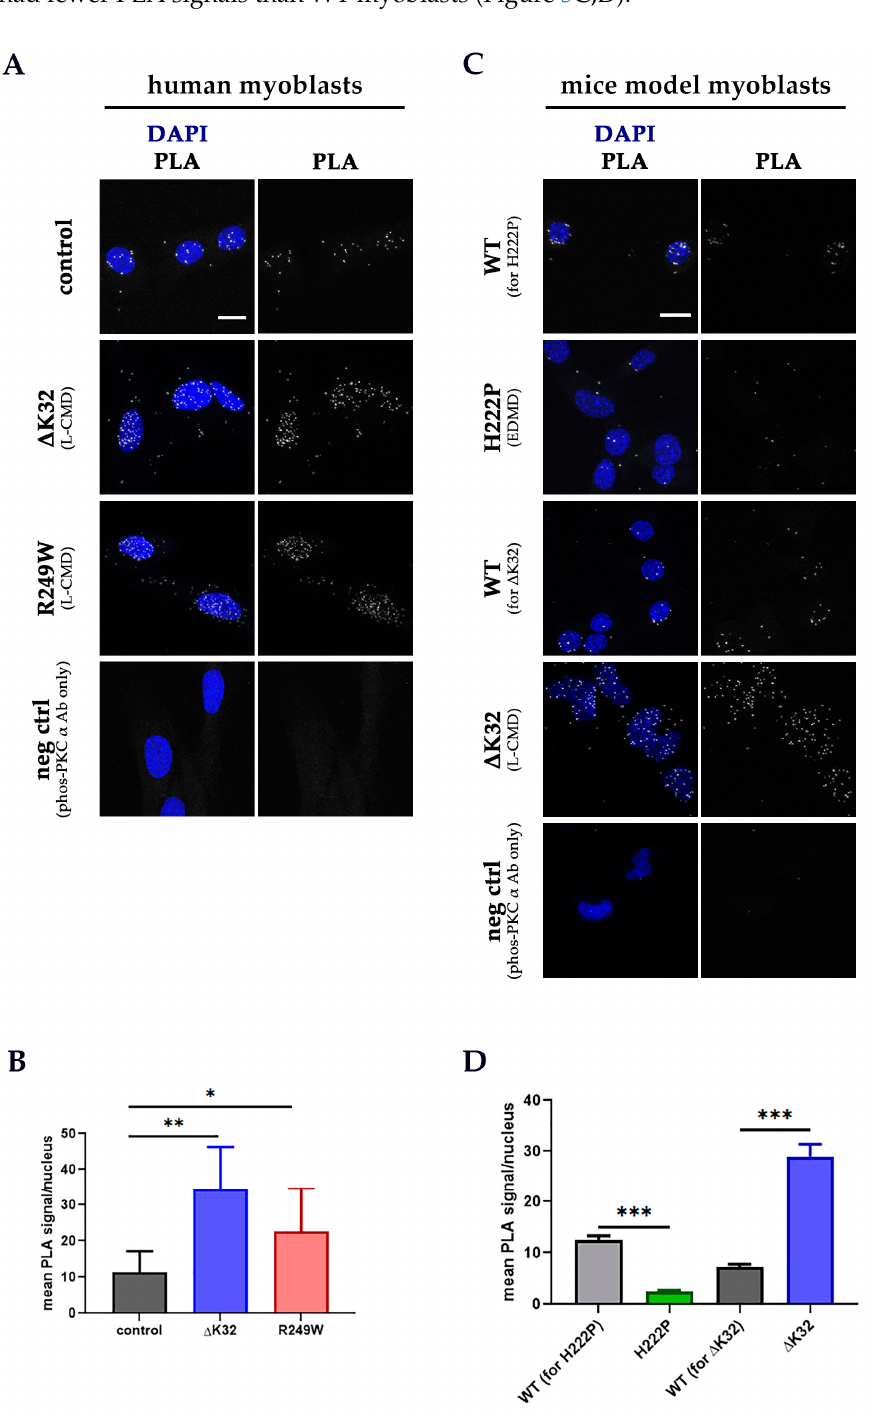
Figure 5. Proximity ligation assay (PLA) between lamin A / C and phos-PKC- α in human ( A ) and mouse model ( C ) myoblasts. Mean ( ± SEM) PLA signal / nucleus in human ( B ) and mouse model ( D ) myoblasts. Each nucleus was stained with DAPI (blue) and the PLA signal representing the proximity of lamin A / C and phos-PKC- α is in white. n = 2 technical replicates (one patient / group; ≥ 92 nuclei / group were analyzed) for human myoblasts and n = 1 experimental set ( ≥ 46 nuclei / group were analyzed) for mouse models’ myoblasts. Scale bar: 15 µ m for all PLA images. Significance (*) was set at p < 0.05; ** means p < 0.01 and *** means p <